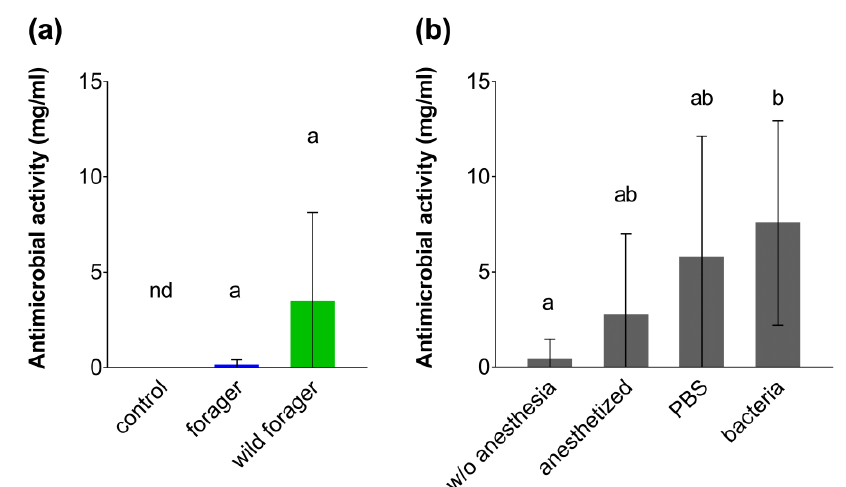
Figure 4. Antimicrobial activity in the Bombus terrestris hemolymph expressed as the concentration of lysozyme with equal antimicrobial effect. ( a ) Constitutive antimicrobial activity was measured in the pooled hemolymph samples from non-foraging control, foraging and wild bumble bees ( n = 4; five animals per biological replicate which means 20 bumble bee workers per each group). ( b ) To induce the antimicrobial activity, the laboratory-reared bumble bee workers were immunized by injection of bacteria and compared to naïve individuals without CO 2 anesthesia, CO 2 anesthetized and phosphate buffer (PBS) injected bumble bees ( n = 7 – 8; five animals per biological replicate which means at least 35 bumble bee workers per each group). Data presented as mean ± SD; nd = not detected activity; significant differences p < 0.05 are indicated by different letters above the columns (Dunn’s test).